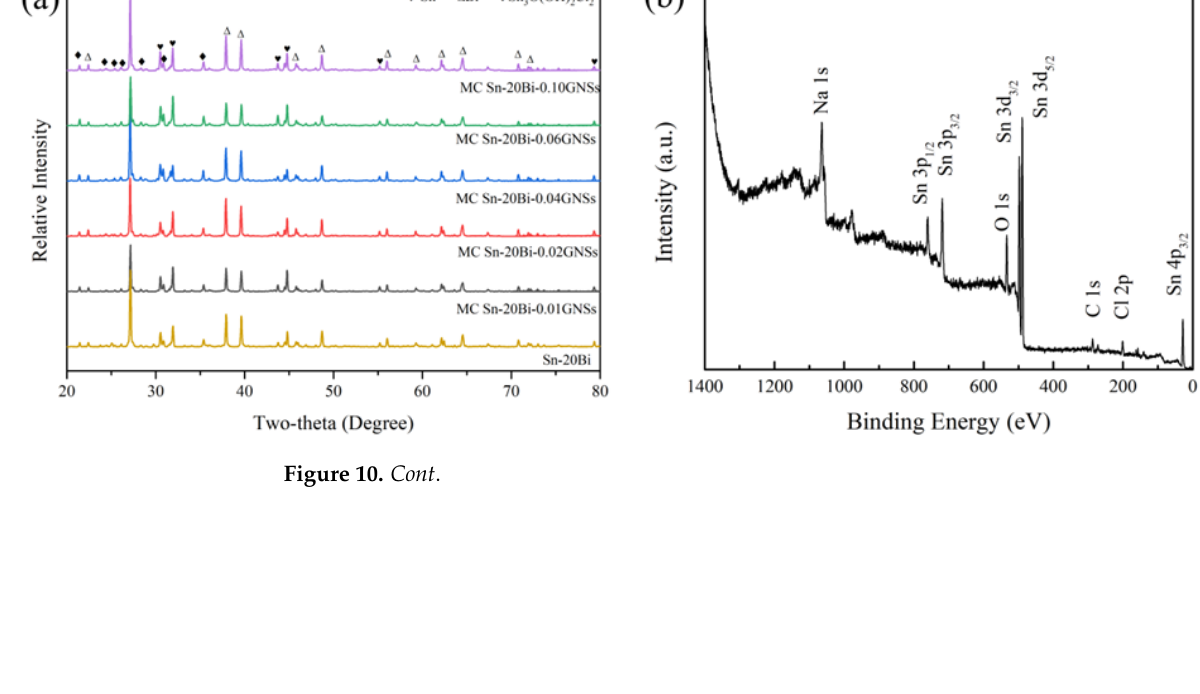
Figure 10. XRD patterns of MC Sn-20Bi- q GNSs solders after electrochemical corrosion; ( b ) XPS scan full spectrum of MC Sn-20Bi-0.02GNSs solder after electrochemical corrosion; ( c – e ) XPS fitting re- sults of MC Sn-20Bi-0.02GNSs after electrochemical corrosion: ( c ) Sn 3d5/2, ( d ) O 1s, and ( e ) Cl 2p. To determine the corrosion reaction, XPS was used to analyze the solder corrosion products, and the results are shown in Figure 10b – e The results show that the peaks of Sn 3d, Sn 3p, Sn 4p, O 1s, Cl 2p, Na 1s, and C 1s are present in the full spectrum of Figure 10b. Figure 10c – e shows the split peak fits of the narrow sweep peaks of Sn 3d5/2, O 1s, and Cl 2p. The results showed that the Sn 3d 5/2 spectrum contains three fitted peaks of 487.1 eV (Sn 4+ ), 486.5 eV (Sn 2+ ), and 485.4 eV (Sn 0 ); the binding energies of the two fitted peaks of O 1s are 531.1 eV and 529.6 eV, respectively, corresponding to hydroxide and oxygen in oxide [23]; the Cl 2p spectra were fitted by two peaks of 200.2 eV and 198.2 eV, which correspond to the Na-Cl and Sn-Cl compounds, respectively.